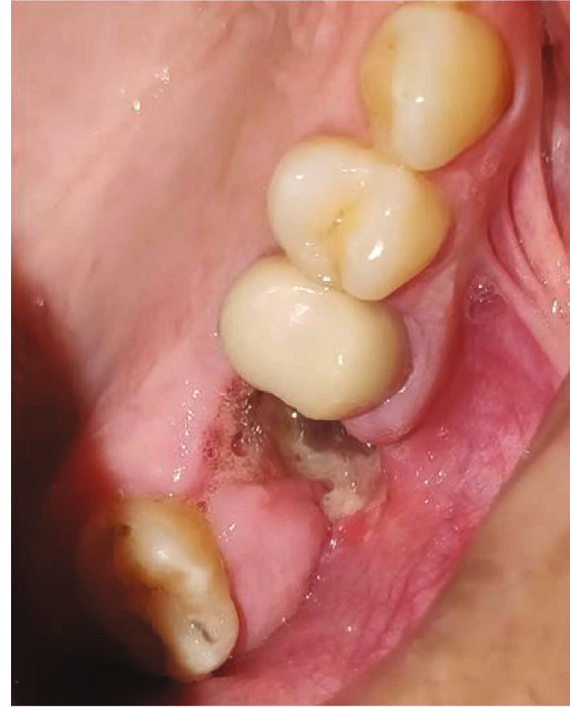
Figure 8: Intraoral view of a recent purulent left maxillary OAC.